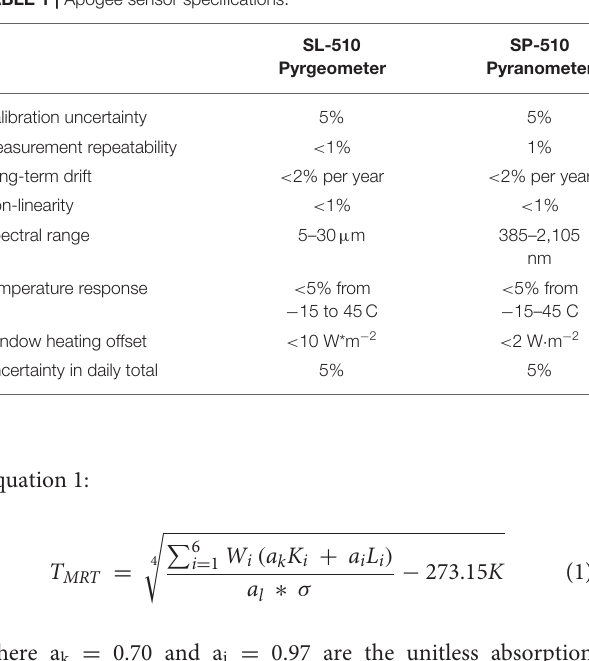
TABLE 1 | Apogee sensor